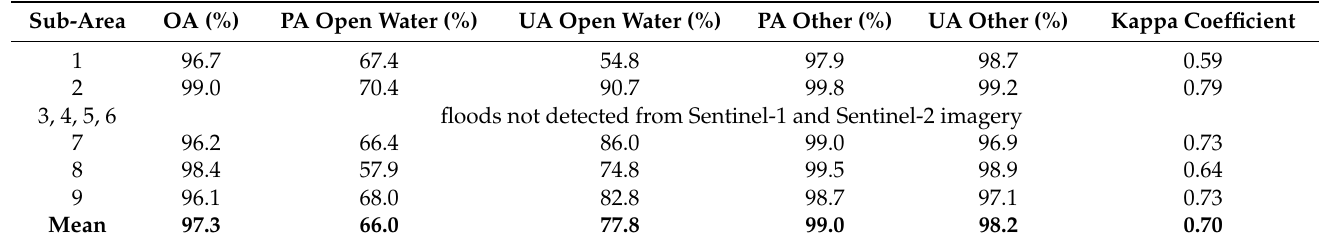
Table 1. Statistical evaluation of comparison between flood extent detected by the developed solution and digitized from Sentinel-2 imagery for the Germany 2017 event. OA—overall accuracy, PA—producer accuracy, UA—user accuracy.